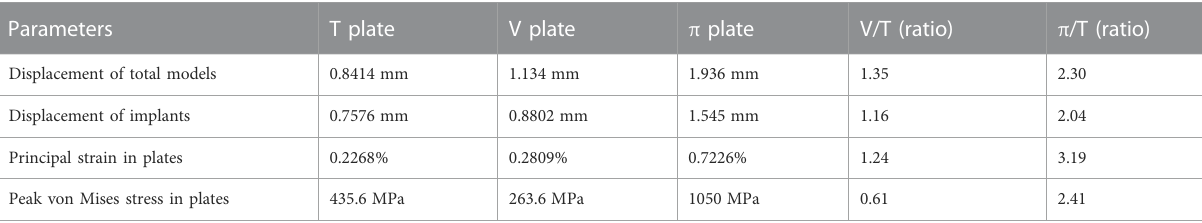
TABLE 1 Analysis results after axial loading simulation.